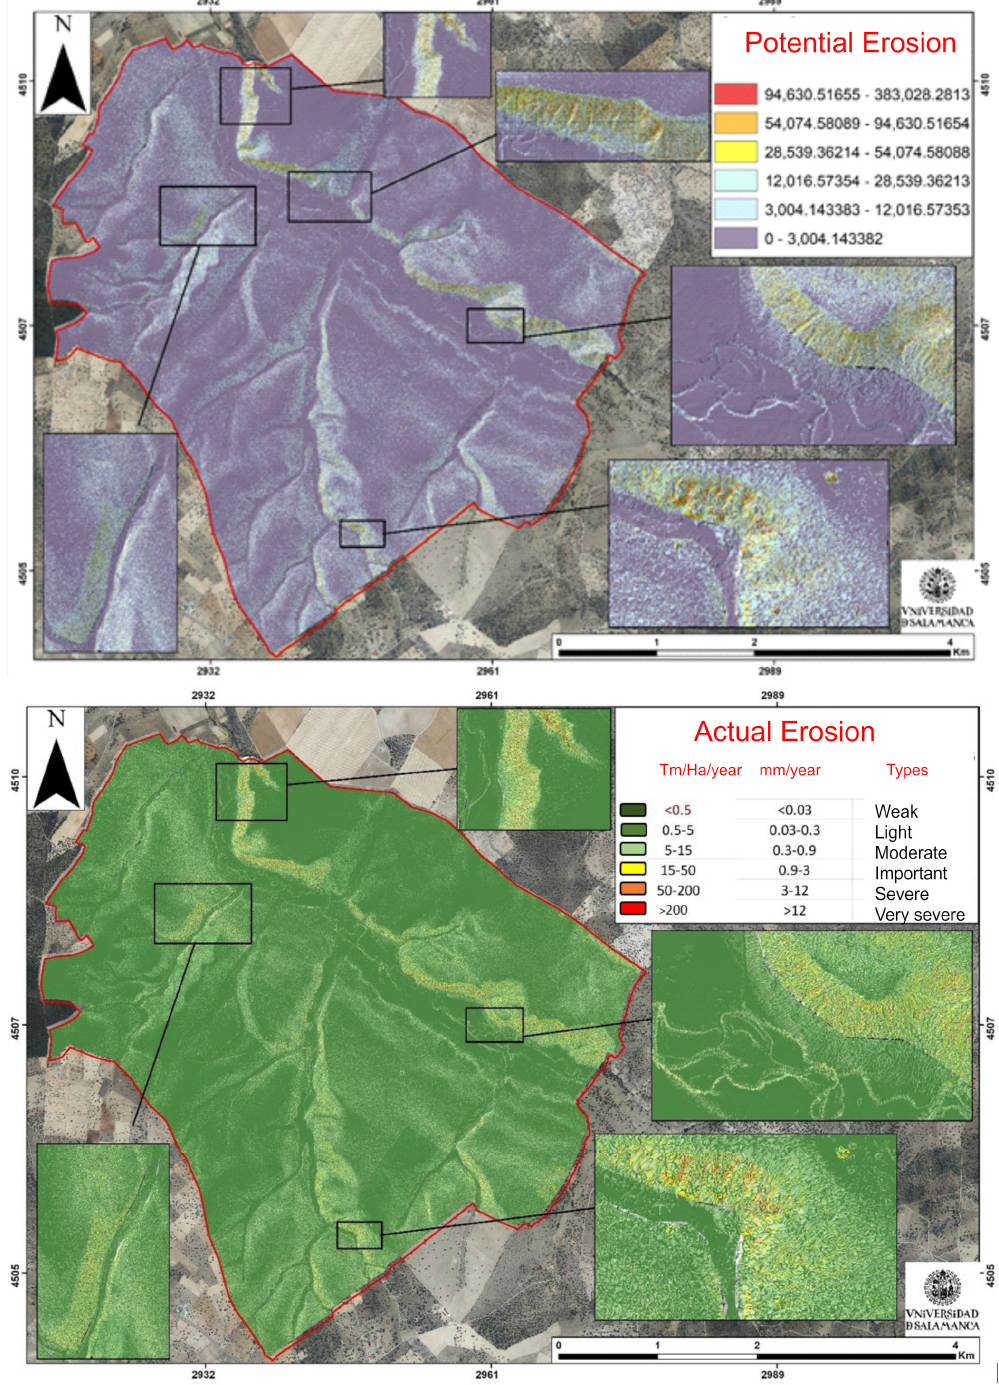
Figure 9. Cartographies with the distribution of the potential erosion risk expressed in Tm/Ha/year ( Top ) and the actual erosion risk ( Bottom ).